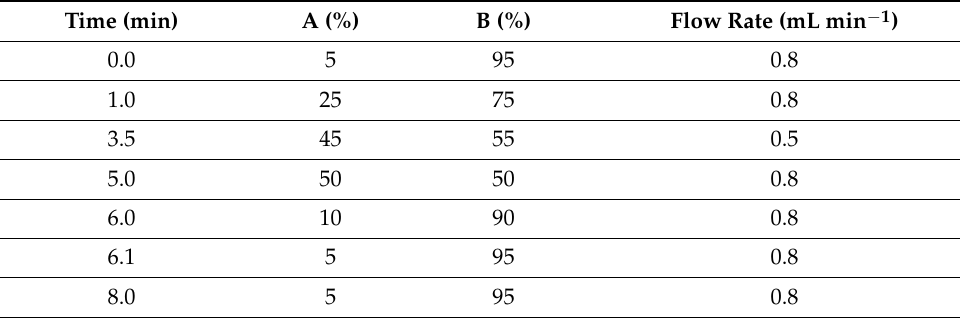
Table 2. Selected gradient elution program.